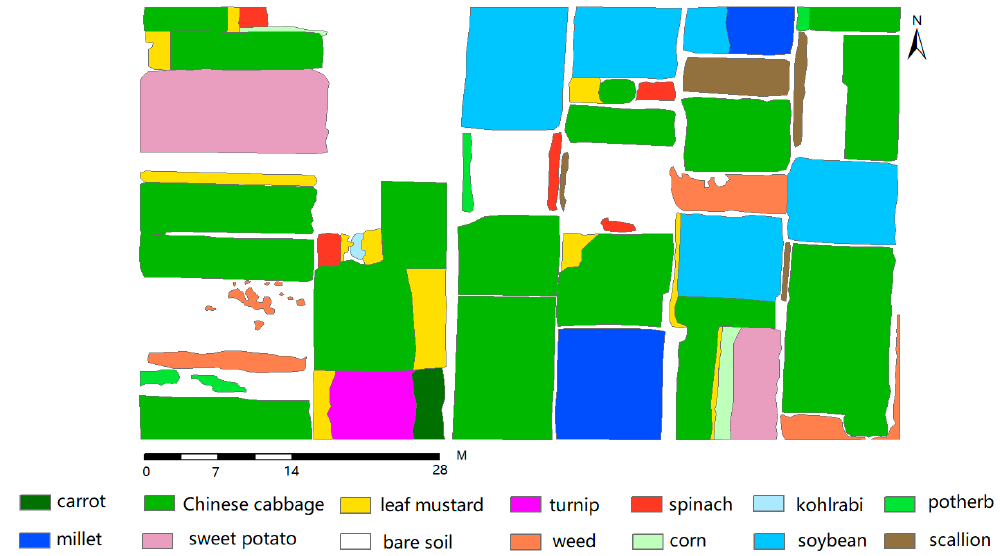
Figure 8. Ground truth map vectorized from the UAV data.